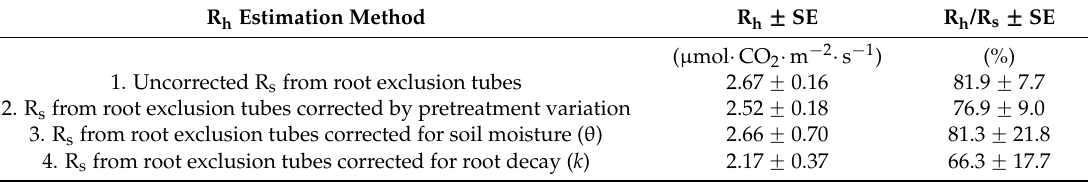
Table 4. Mean heterotrophic respiration (R h ) and the ratio of R h to total soil respiration (R s ) from control collars by R h estimation method. Mean R s from control collars was 3.27 ˘ 0.16 µ mol ¨ CO 2 ¨ m ´ 2 ¨ s ´ 1 .